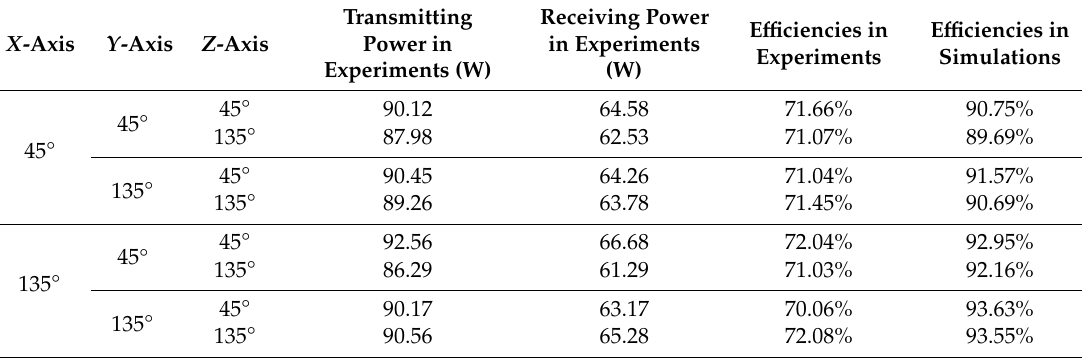
Table 3. Experimental results of directivity when receivers rotate over three axes.